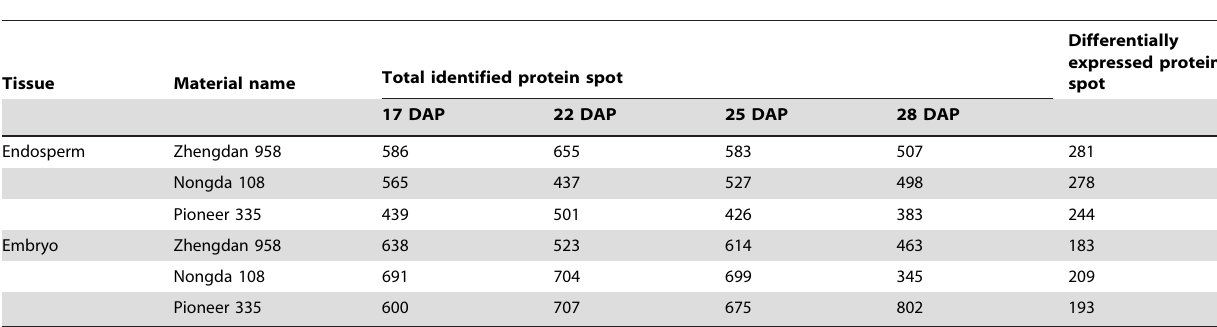
Table 1. Number of differentially expressed protein spots in endosperm and embryo of the three maize hybrids at different sampling times during grain